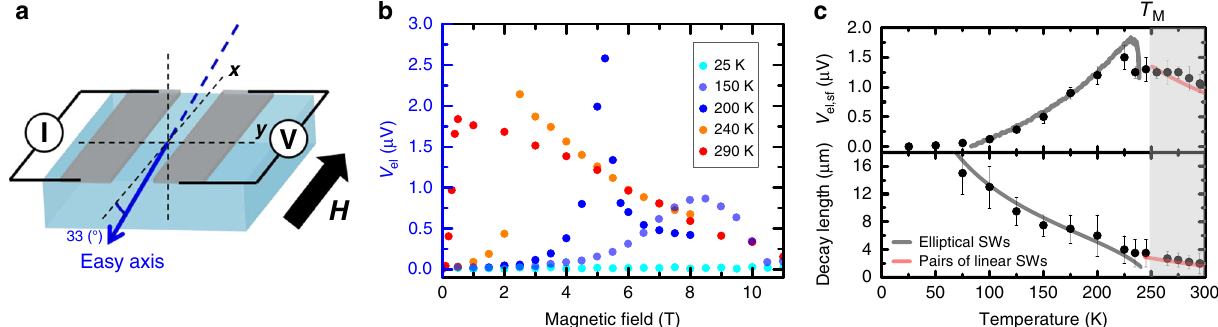
Fig. 1 Spin transport through the Morin transition ( T M ). a Schematic of the nonlocal geometry of two electrically isolated Pt wires parallel to the in-plane projection of the easy axis. b Temperature dependence of the nonlocal spin signals for a magnetic fi eld parallel to the platinum stripes (33 deg from the easy-axis). Error bars from counting statistic are smaller than the symbol size. c Top: The spin signal V el is measured at the spin- fl op fi eld and approaches zero at low temperature, indicating a diffusive regime. Data obtained for an inter-stripe distance of 500 nm. Bottom: Spin-wave decay length (spin-diffusion length λ for T < T M and dephasing length L for T > T M ) as a function of temperature for H applied along x at the spin- fl op fi eld (gray and red lines, respectively, correspond to fi ts with a magnon transport based on elliptically polarized spin waves (SWs) and on pairs of linearly polarized spin waves. The gray line would go to zero above the Morin transition due to the absence of elliptical spin waves. For modeling we used the following data: exchange fi eld H = 1040 T, H = 2.72 T, H = 24 μ T as in ref. 27 ex DMI an,in